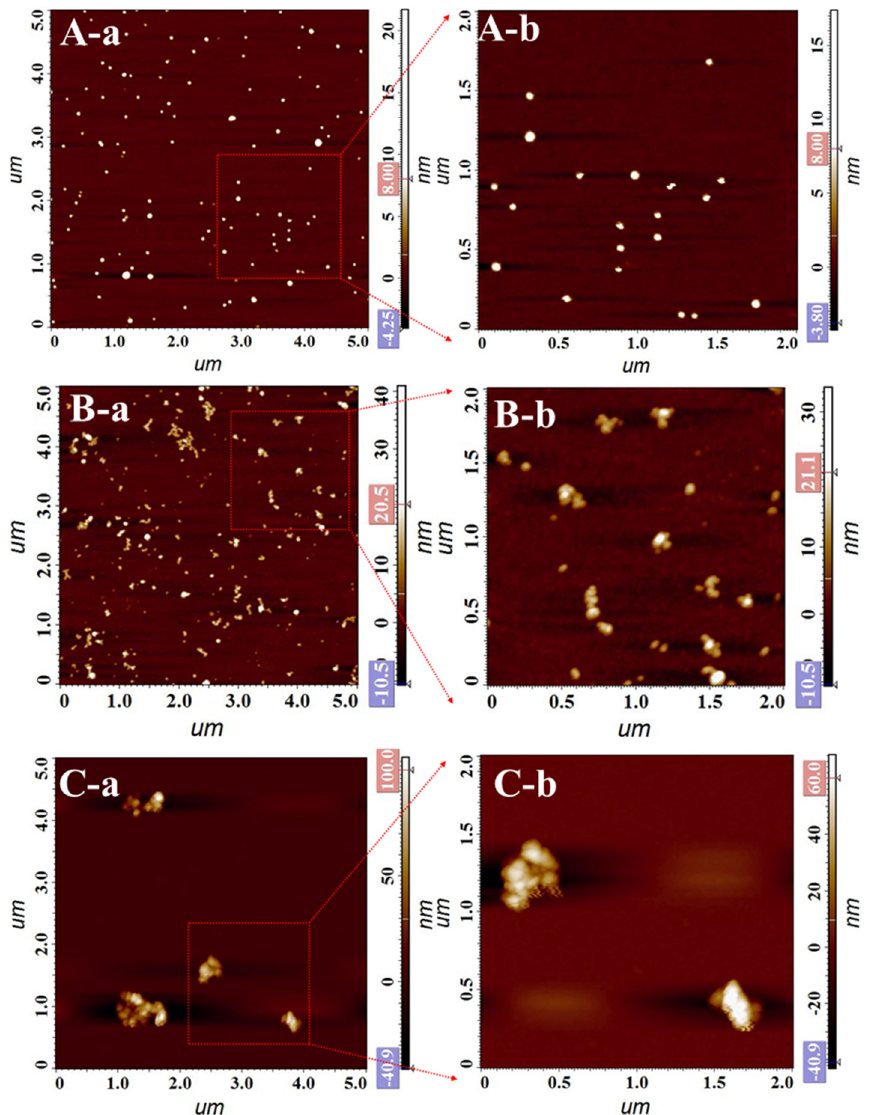
Figure 5. AFM images of AuNPs and gold nanocomposites (( A ): AuNPs; ( B ): AuNPs@Ru(bpy) 32+ ; ( C ): AuNPs@Ru(bpy) 32+ -SA).